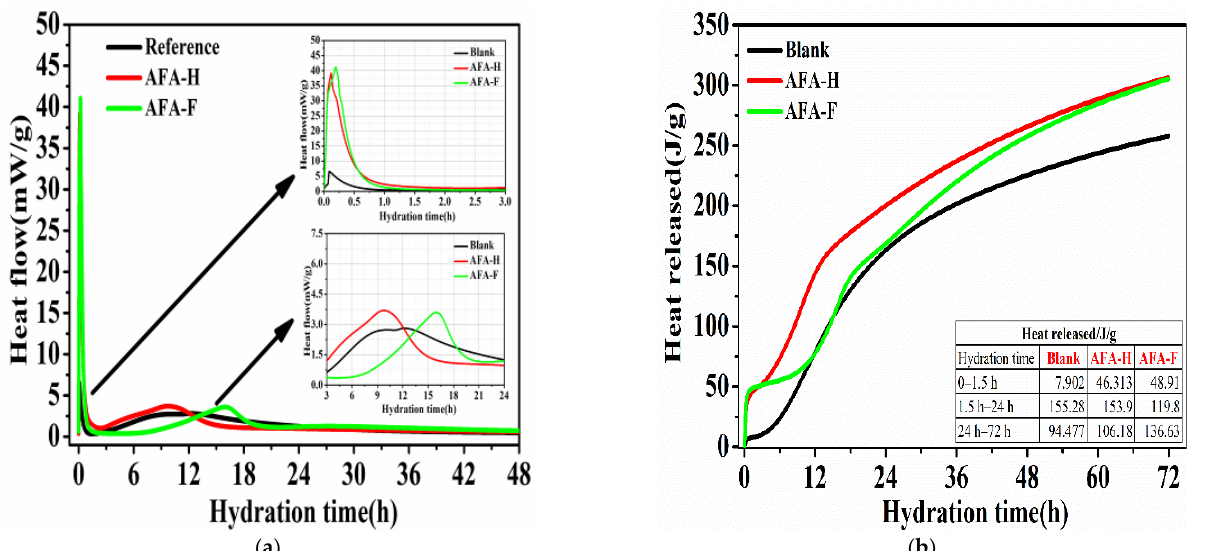
Figure 1. Heat flow ( a ) and heat released ( b ) curves of the cement paste containing liquid alkali-free accelerators with and without fluoride during the first 72 h of hydration at room temperature.